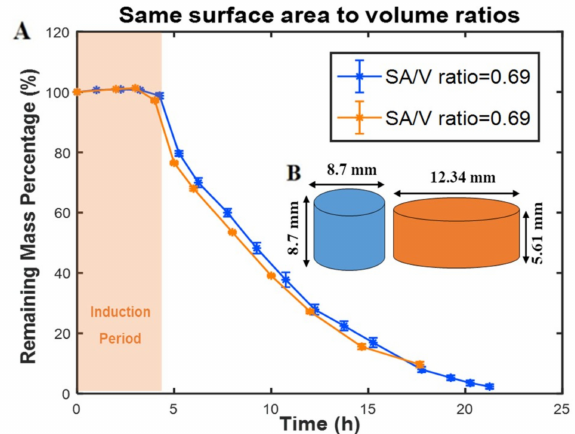
Figure 4. The e ff ect of geometry on the mass loss profile of PAHs. ( A ) Remaining mass percentage of two tablets with the same SA / V ratio while both surface areas and volumes are di ff erent. ( B ) Schematics of tablet designs and dimensions. All experiments were conducted at 37 ◦